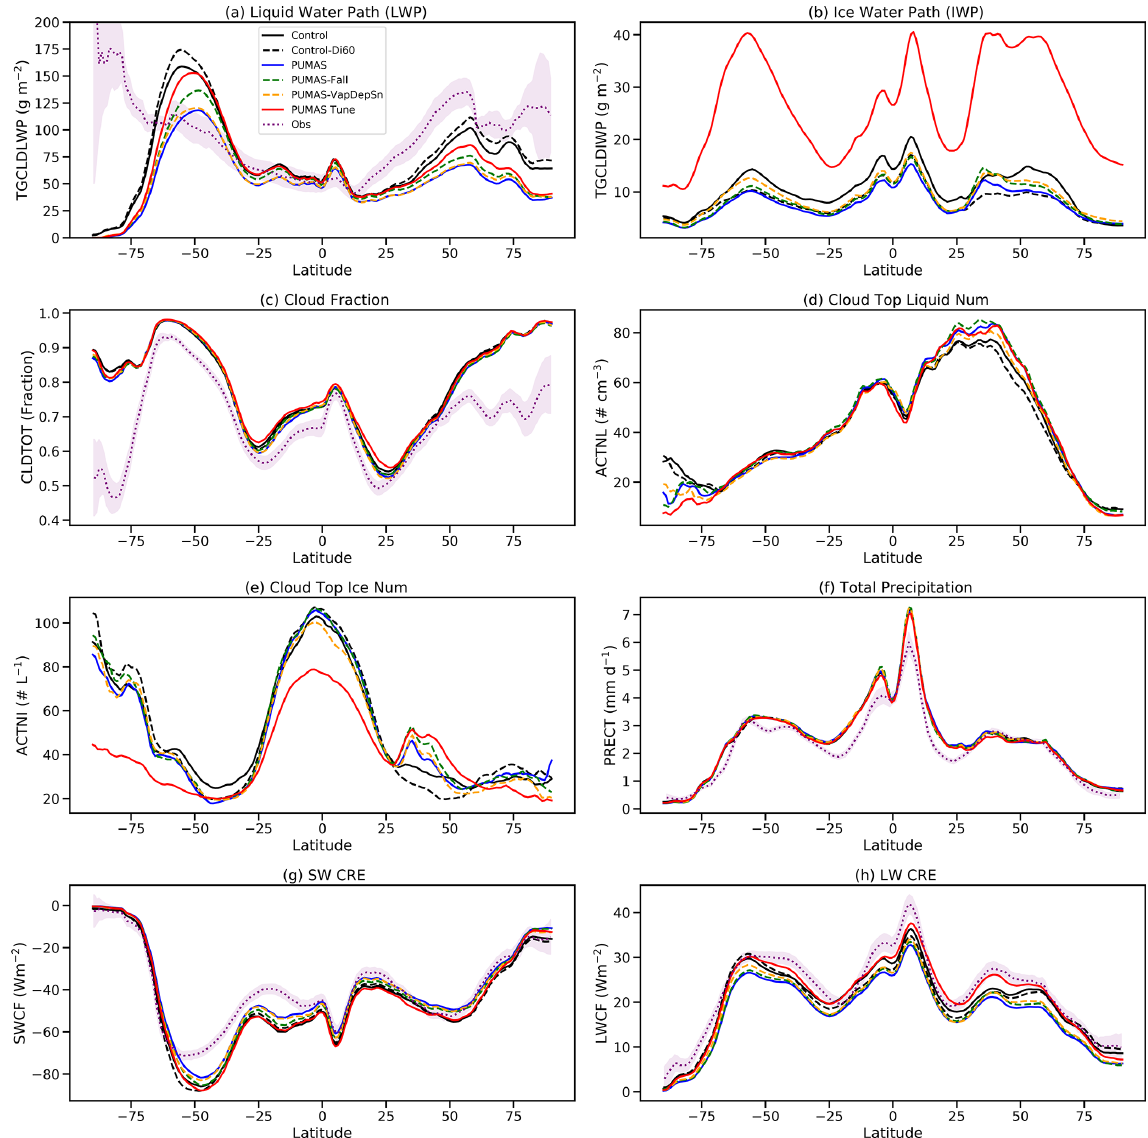
Figure 6. Zonal mean annual averages from 6-year global simulations for the MG3 control (black), PUMAS (blue), PUMAS-Fall (green), PUMAS-VapDepSn (orange), and PUMAS-Tune (red). Simulation names are defined in Table 1. Also shown is the CERES EBAF climatol- ogy (purple), with 1 standard deviation of the annual means. (a) Liquid water path (LWP). (b) Ice water path (IWP). (c) Cloud fraction. (d) Cloud-top liquid number. (e) Cloud-top drop number. (f) Total precipitation. (g) Shortwave (SW) cloud radiative effect (CRE). (h) Longwave (LW)